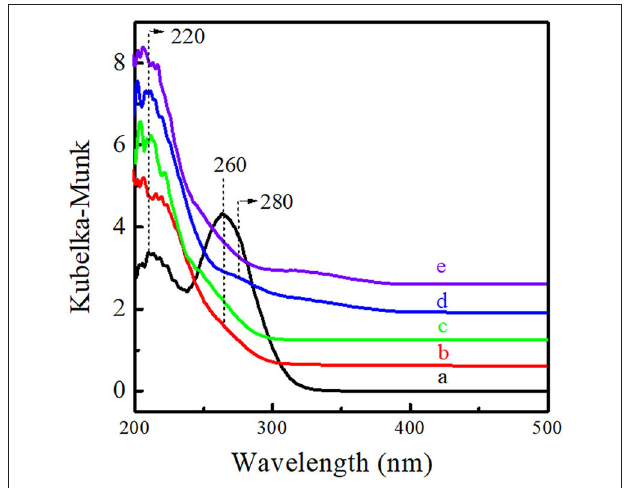
FIGURE 6 | UV-visible diffuse reflectance spectra of Ti-MWW-AM (a), Ti-MWW-AT (b), Ti-MWW (c), R-Ti-MWW-PI (d), and R-Ti-MWW-PI-cal (e).